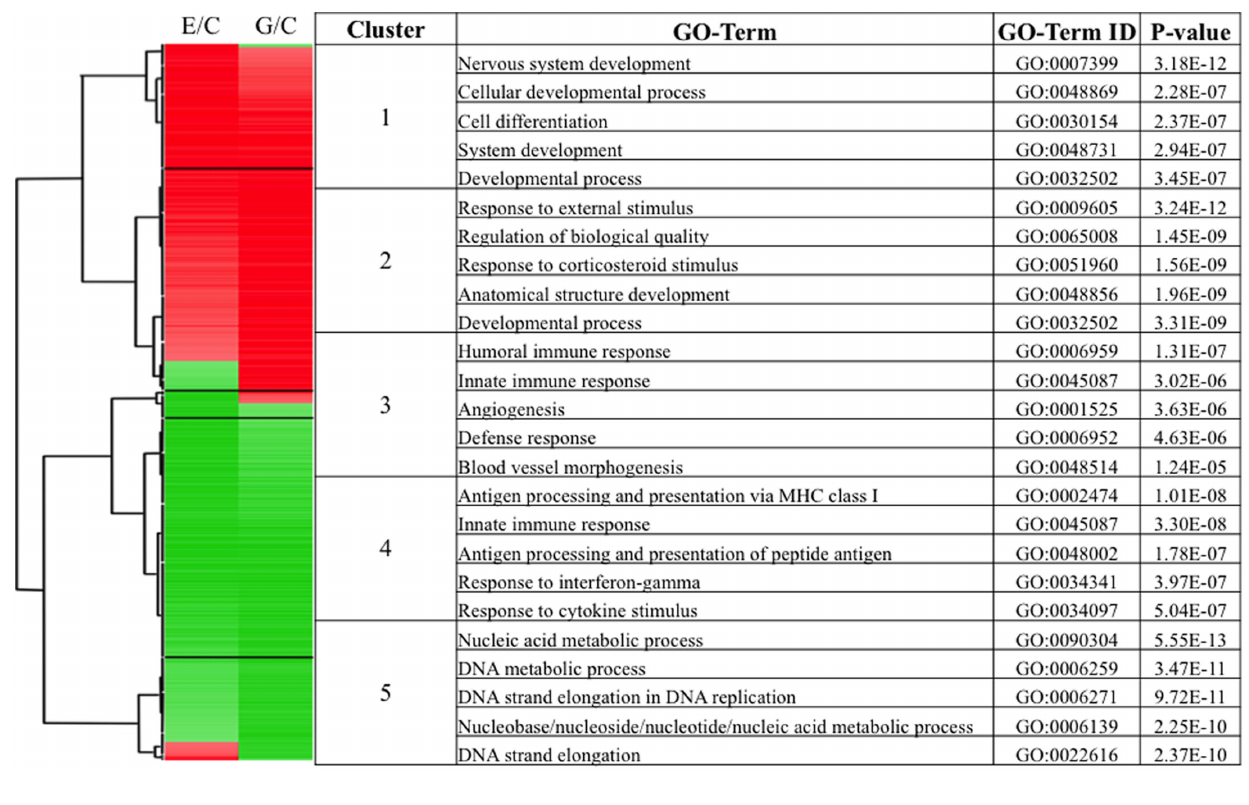
FIGURE 4 | Hierarchical clustering of the most robustly affected NURR1-responsive transcripts identified clusters with distinct concentration-dependence and biological processes. Transcripts included in this clustering were increased or decreased at least twofold in either the E or G cell line (relative to C, ∼ 1700 transcripts).The resulting five